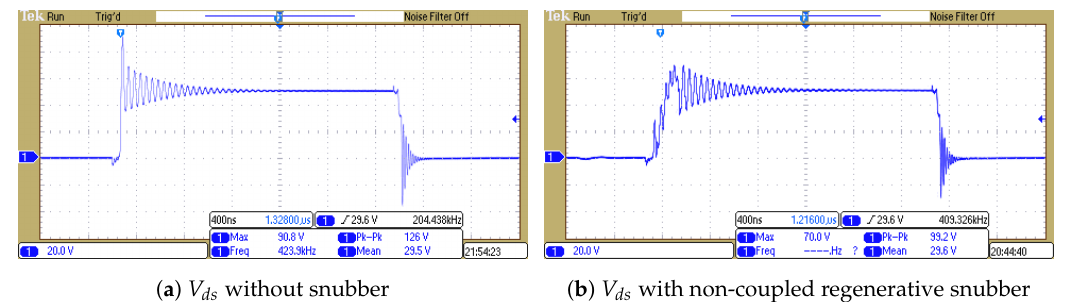
Figure 16. Experimental results for the voltage across the MOSFET switch “ V in = 24 V”.